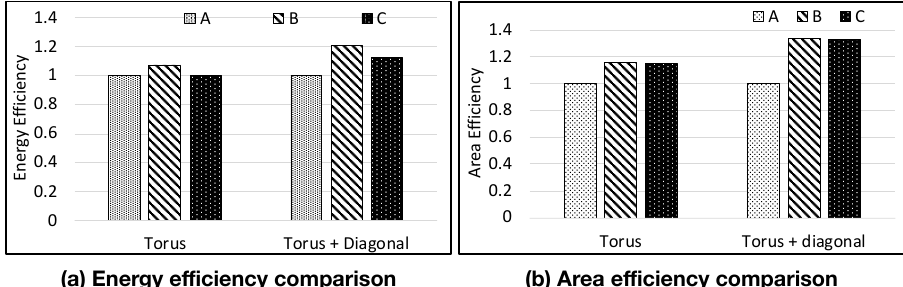
Figure 16. The normalized energy efficiency and area-efficiency